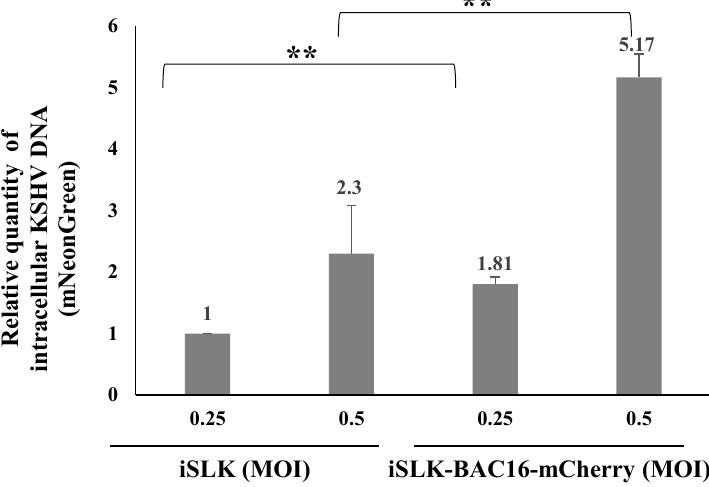
Figure 7. Superinfected cells contain higher levels of incoming viral DNA compared to primary infected cells. Uninfected and latently BAC16-mCherry-infected iSLK cells were infected with BAC16-mNeonGreen at MOI of 0.25 and 0.5 using the spinoculation method. High-molecular-weight DNA was extracted 48 h after infection, and the quantity of incoming viral DNA was measured using primers targeting the mNeonGreen fluorescent gene. The reactions were performed in triplicate, and the mean values obtained for the mNeonGreen fluorescent gene were normalized against the mean values obtained in the corresponding reactions of the ERV-3 cellular gene. DNA levels are shown relative to iSLK cells that were infected with BAC16-mNeonGreen virus at an MOI of 0.25, which was defined as 1 after normalization. Results obtained are from three independent experiments. Statistical analysis was performed using the ANOVA test and t -test. ** p < 0.01.